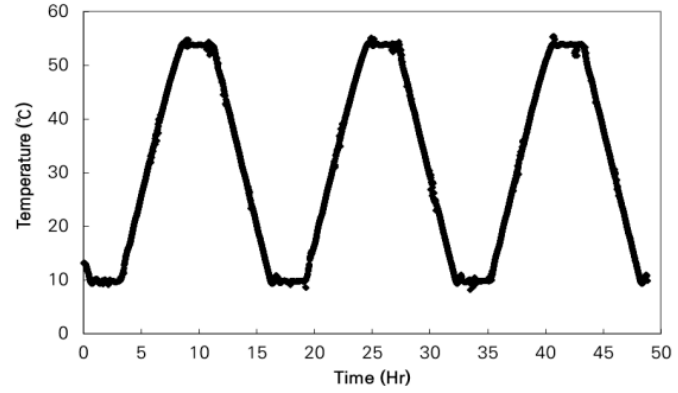
Figure 3. Typical temperature cycle applied to concrete specimens [45].